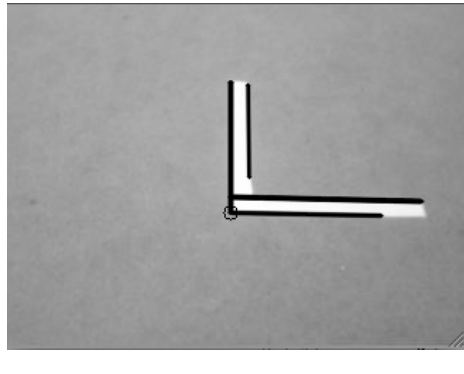
Figure 12. L-shape recognized on an image (a corner of the game field). This pattern helps us to obtain camera